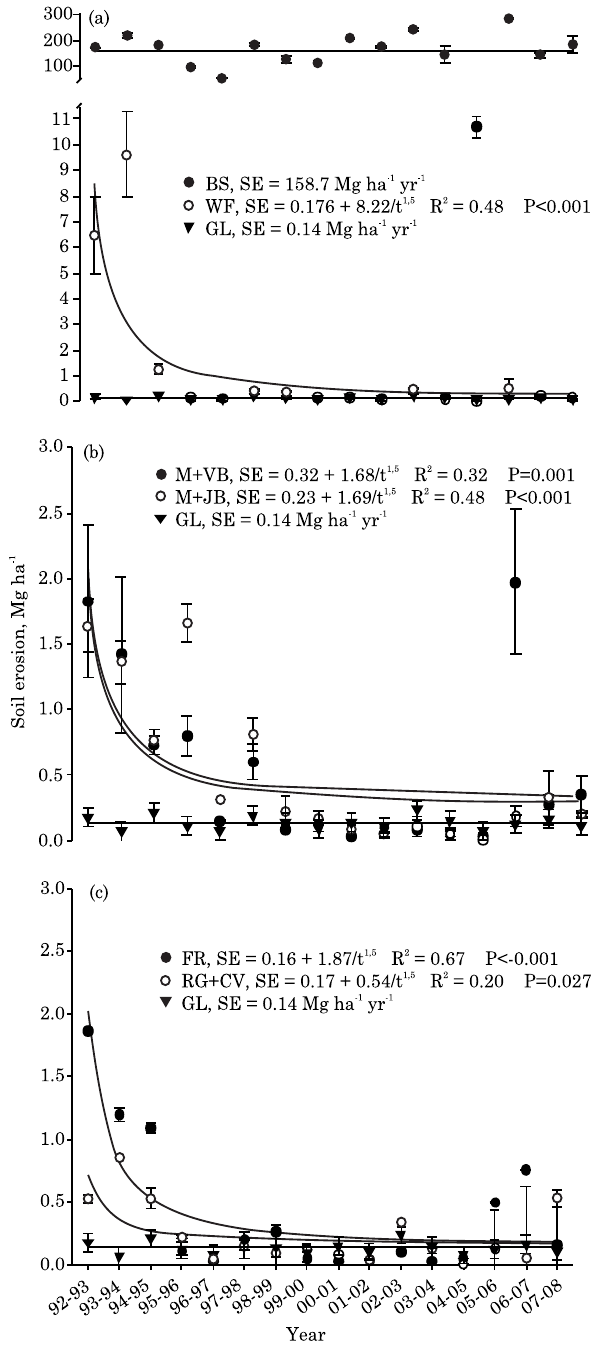
Figure 1. Soil losses from treatments BS, WF and GL (a) M+VB, M+JB and GL (b) and FR, RG+CV and GL (c) treatments as a time function (years) in a long-term experiment in Santa Maria, RS, Brazil. Vertical bars are mean standard errors (n=2). BS: Bare soil; WF: Winter fallow; M+VB: intercrop maize - velvet bean; M+JB: summer consortium maize - jack bean; FR: forage radish; RG+CV: winter consortium ryegrass - common vetch; GL: grassland. Soil losses from GL treatment was repeated in all graphs for better